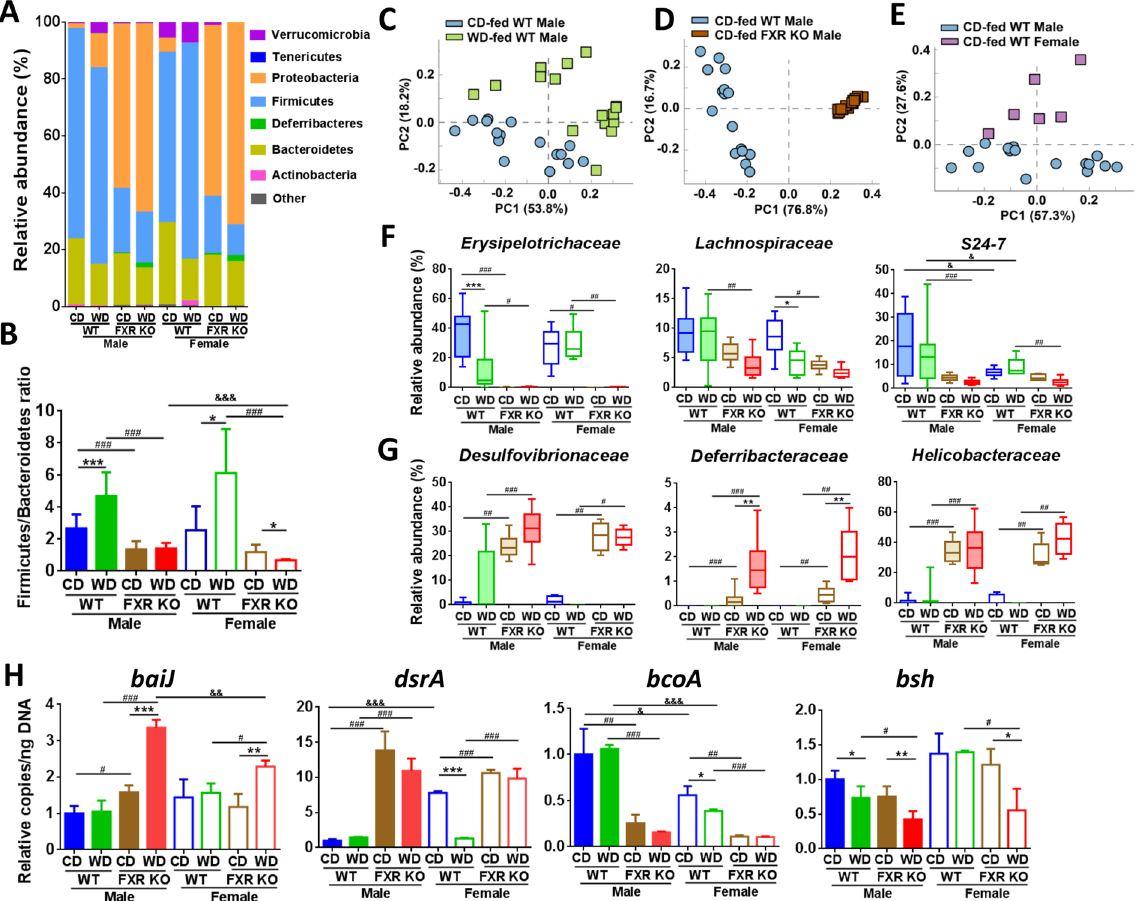
Figure 5. Diet and FXR deficiency changed gut microbiota composition in both genders. ( A ) Cecal microbiota at phylum level. ( B ) Firmicutes to Bacteroidetes ratio. Principal component analysis plots of cecal microbiota at family level based on diet ( C ), phenotype ( D ), and gender difference ( E ). ( F ) and ( G ), relative abundance of cecal microbiota at family level (Kruskal-Wallis test). Box plots display the median, 25th percentile, and 75th percentile; whiskers display minimum and maximum values. (H) Targeted functional quantitative PCR analysis of microbial genes. ( B , H ), data are expressed as mean ± SD. One-way ANOVA with Tukey’s correction. n = 16 in male groups, n = 6 in female groups. * p < 0.05, ** p < 0.01, *** p < 0.001 for diet comparison; # p < 0.05, ## p < 0.01, ### p < 0.001 for genotype comparison; & p < 0.05, && p < 0.01, &&& p < 0.001 for gender